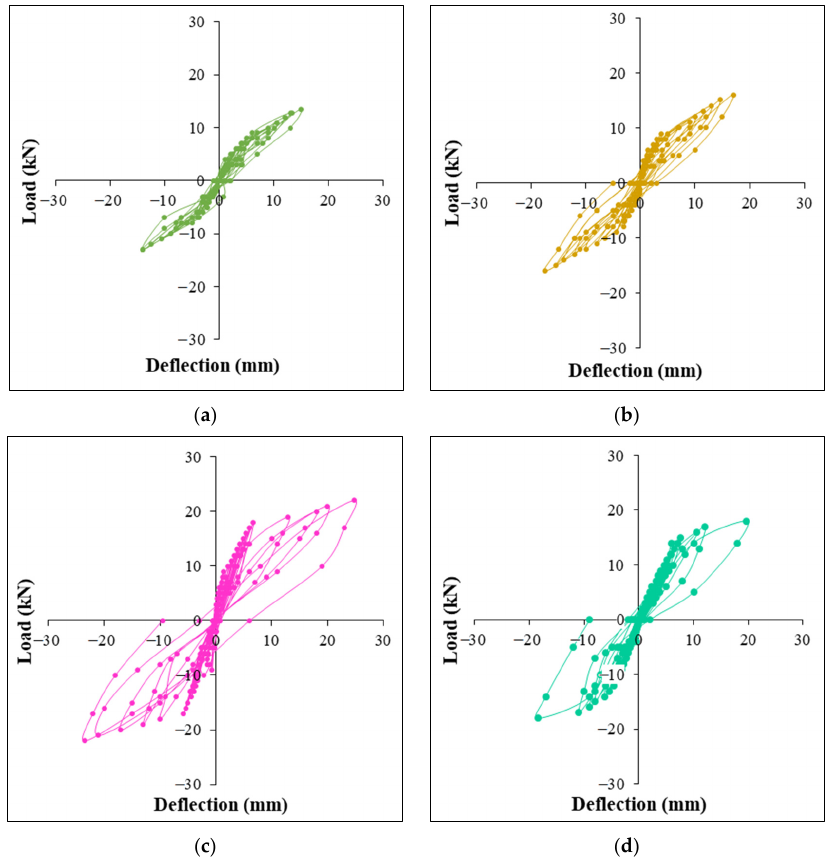
Figure 5. Typical load-deflection plots: ( a ) TGPC, ( b ) HTGPC1, ( c ) HTGPC6 and ( d ) HTGPC8.